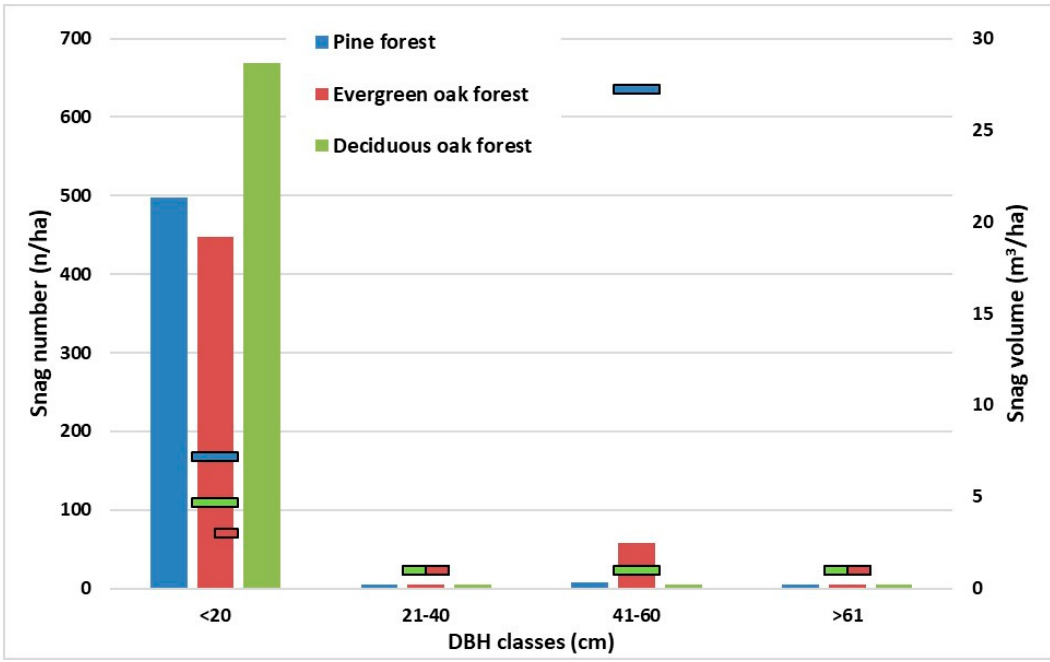
Figure 4. The histograms show the number of snags referred to diametric (DBH) distribution in each forest type (left y-axis) . The scatter bars show the snag volume referred to diameter (DBH) distribution in each forest type (right y-axis).